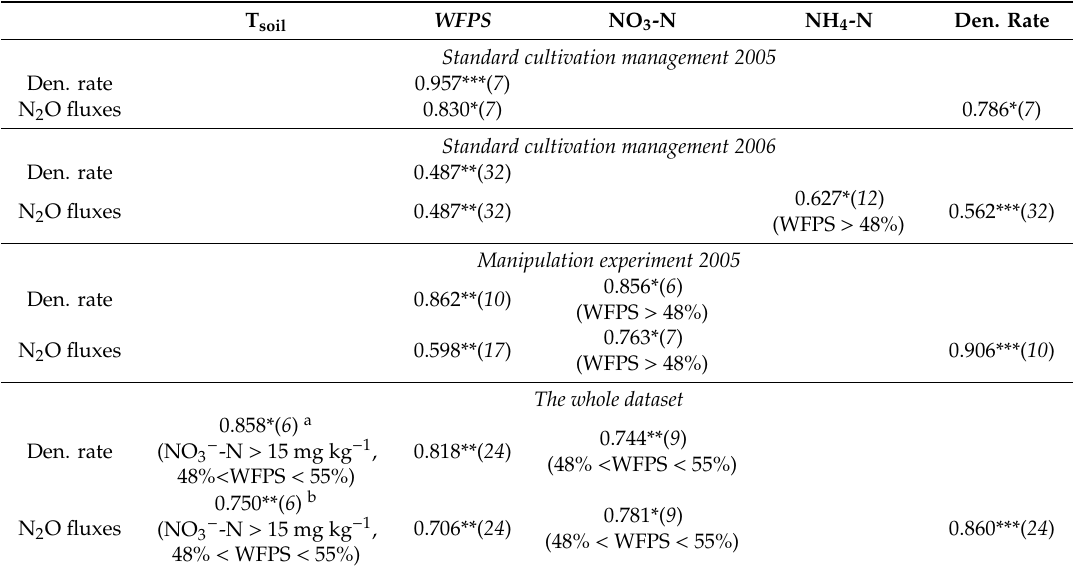
Table 2. Coe ffi cients for the significant correlations between the N 2 O emissions, the denitrification rate (Den. rate) and the driving ancillary parameters. Pearson Product- Moment Test: * P < 0.05; ** P < 0.01; *** P < 0.001. The numbers reported in parentheses in Italic font show the samples size. T soil : soil temperature; WFPS: water filled pore